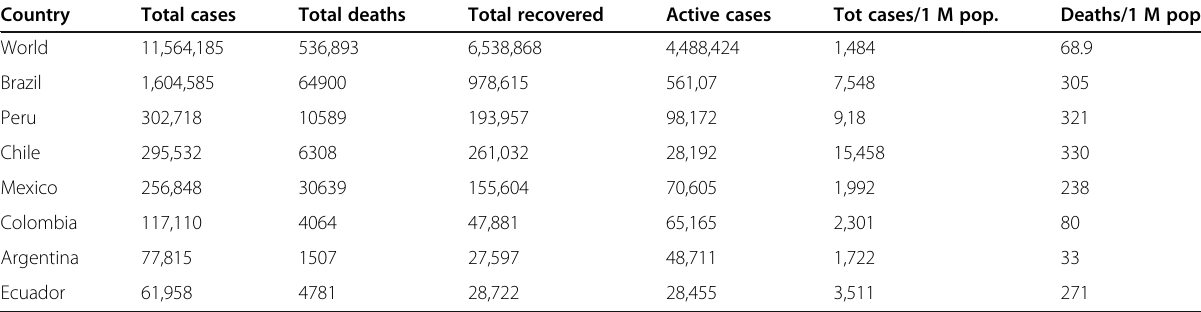
Table 1 Covid-19 statistics for selected Latin American countries Country Total cases Active cases Tot cases/1 M